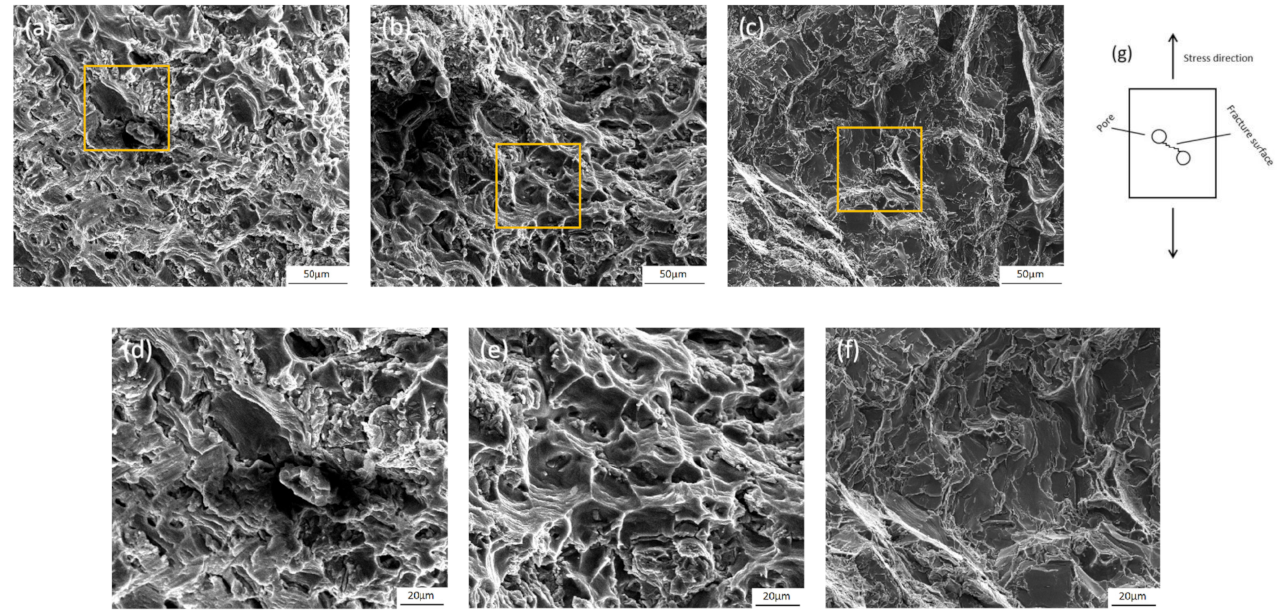
Figure 6. Fracture morphology of ( a ), ( d ) Al-Cu; ( b ), ( e ) Al-Cu-La; ( c ), ( f ) Al-Cu-La-Sc alloys. ( g ) Effect of pores on fracture